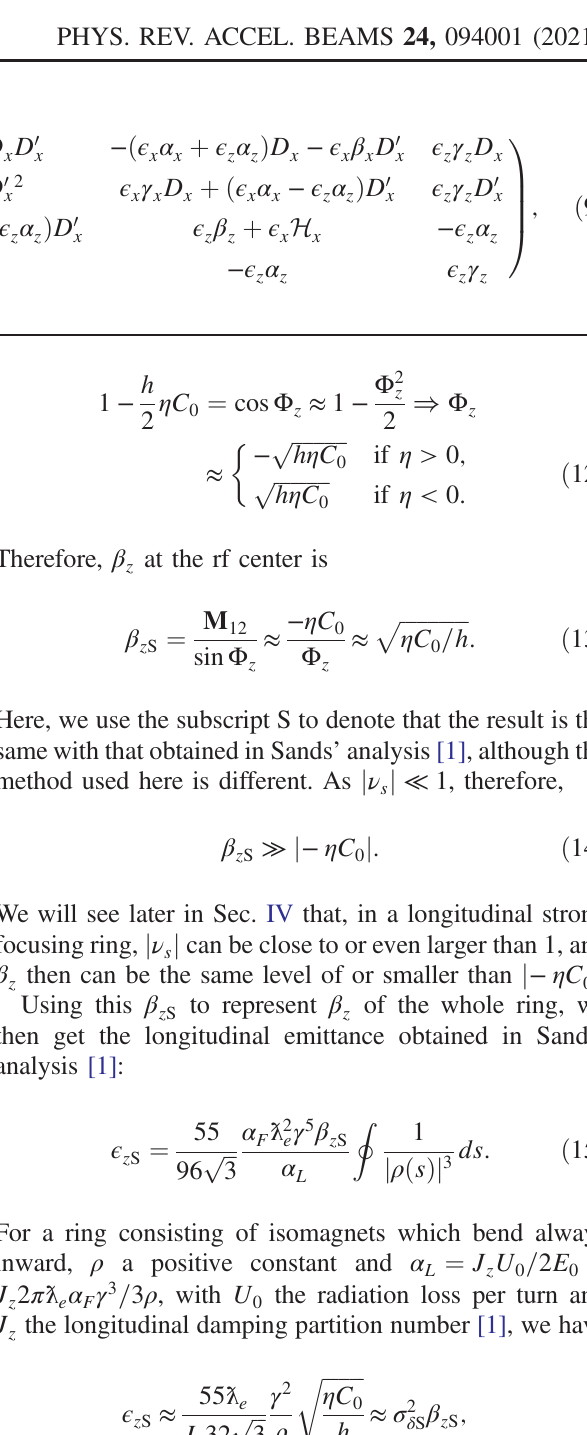
p ffiffiffiffiffiffiffiffiffiffiffiffiffiffiffi ffiffiffiffiffiffiffiffiffiffiffiffi ϵ γ z S z S